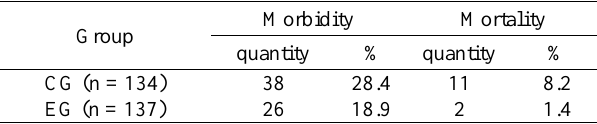
Prophylactic effectiveness of XTRACT™ 6930 for non- contagious diseases of the gastrointestinal tract of piglets during the period of